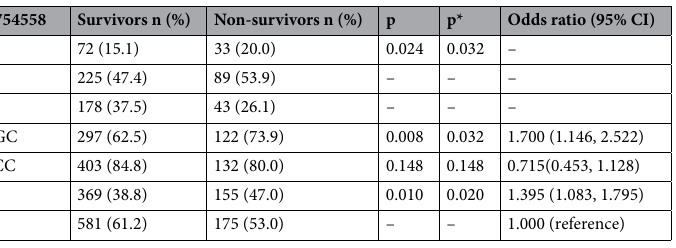
Table 4. Genotype and allele frequencies distribution of the NLRP3 rs10754558 in the 28-day surviving and non-surviving sepsis patients. 95% CI 95% confidence interval. *False discovery rate-adjusted p-value for multiple hypotheses testing using the Benjamini–Hochberg method.